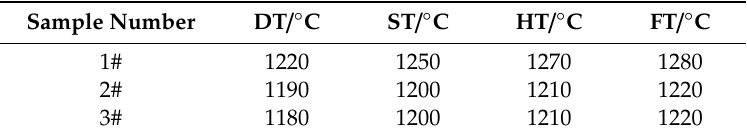
Figure 7. The plot of logarithmic scales (base 10) for the pre-exponential factor vs. activation energy using values reported in Table 1. Table 4. Ash fusibility temperatures (AFTs) ( ◦ C) of Shenhua bituminous coal with di ff erent particle sizes.